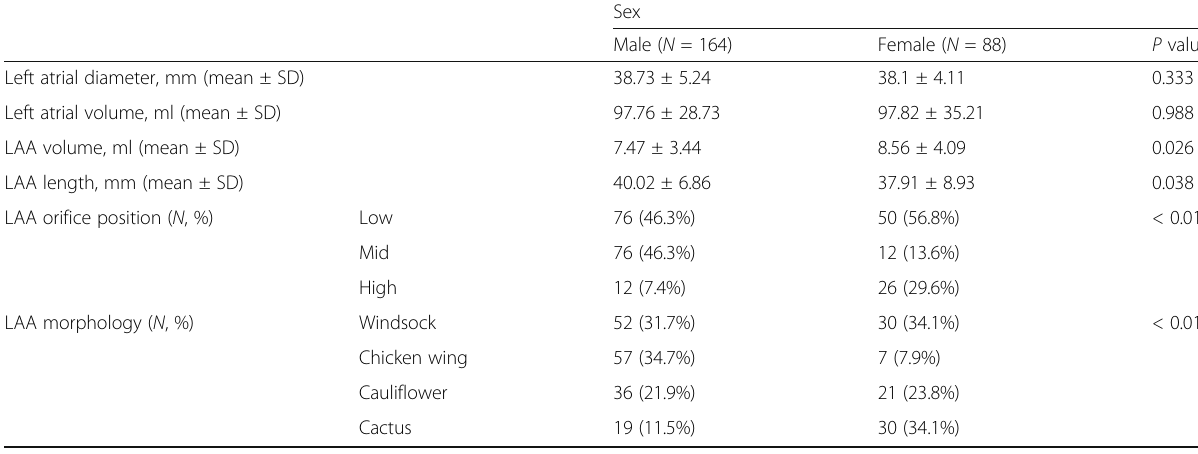
Table 3 Differences in the left atrium and left atrial appendage dimensions as well as left atrial appendage morphological types between males and females